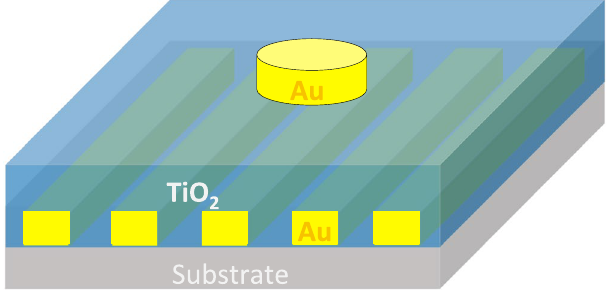
Figure 9. Alternative design of narrowband absorber for realistic